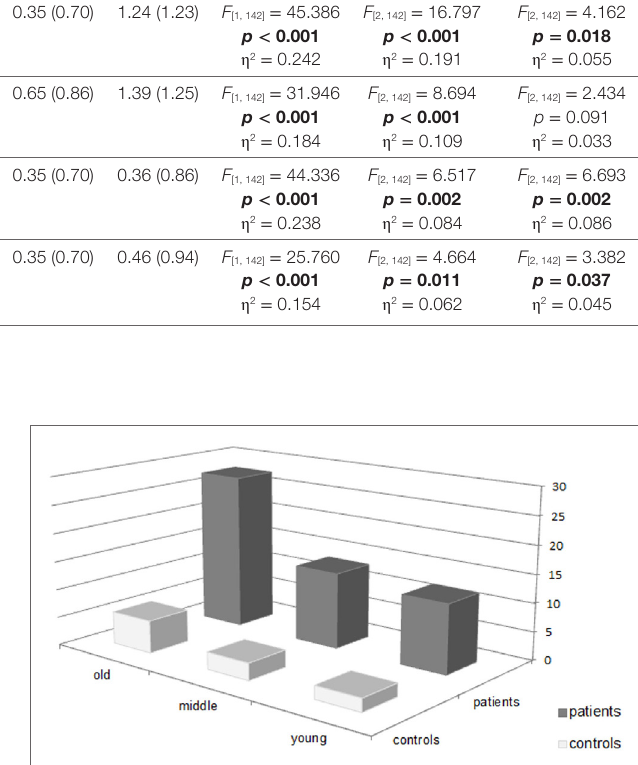
FigUre 1 | Neurological soft signs total scores of patients and healthy controls by age group.